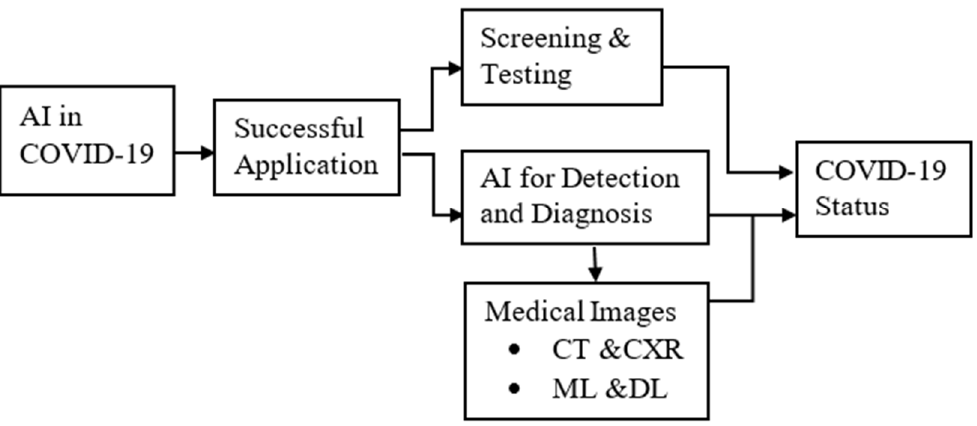
Figure 1. Layout of the paper.